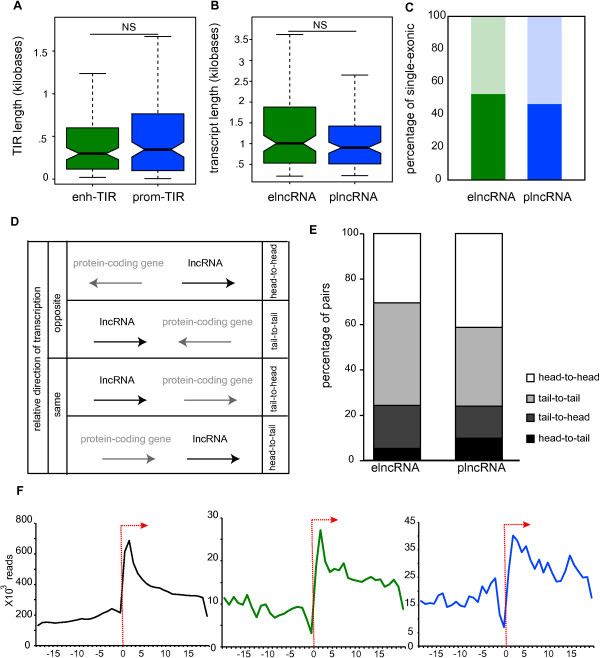
elncRNA and plncRNA loci have similar sequence features. (A) The lengths of elncRNA (enh-TIR, median = 293 nucleotide, green) and plncRNA (prom-TIR, median = 342 nucleotide, blue) TIRs are similar (two-tailed Mann–Whitney test, P = 0.52), (B) as are the lengths of elncRNA (median = 1006 nucleotide) and plncRNA (median = 903 nucleotide) transcripts (two-tailed Mann–Whitney test, P = 0.24). (C) The percentage of elncRNAs that are mono-exonic (47%, dark green) is similar to that for plncRNAs (54%, dark blue, two-tailed Fisher’s exact test, P = 0.37). Light green and blue represent the percentage of multiexonic elncRNAs and plncRNAs, respectively. (D) Relative transcriptional orientation for lncRNAs (black) and their closest protein-coding gene (grey). For simplicity lncRNAs are represented here as transcribed from 5′ to 3′. Arrow represents the direction of transcription. (E) Percentages of lncRNA-protein-coding gene pairs with relative orientation head-to-head (white; elncRNAs = 31%, plncRNAs = 41%); tail-to-tail (light-grey, elncRNAs = 45%, plncRNAs = 35%); tail-to-head (dark-grey; elncRNAs = 19%, plncRNAs = 14%) and head-to-tail (black; elncRNAs = 5%, plncRNAs = 10%). (F) Total number of polyA selected RNA sequencing reads (y-axis) associated with the transcriptional start sites of protein-coding gene (black), elncRNA (green) and plncRNA (blue) meta-genes’ transcriptional start sites (±50 bp, x-axis). Arrow indicates the location of the transcriptional start site and the direction of the meta-gene transcription. NS, not significant.